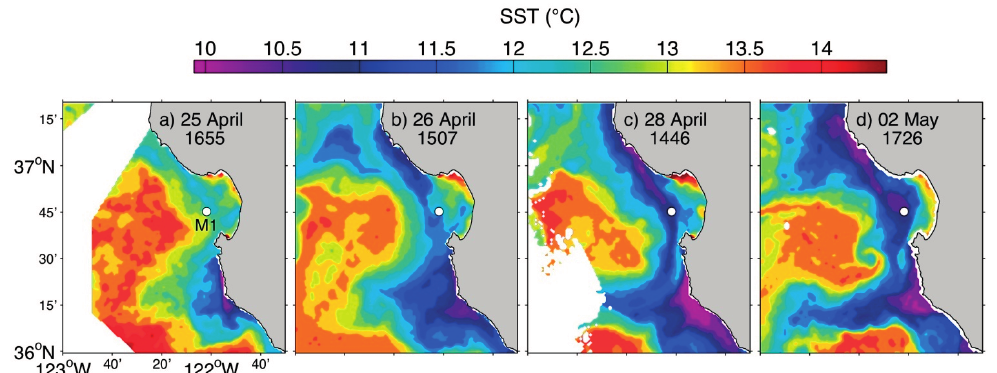
Figure 3. Upwelling intensification during the spring 2011 study. Sea surface temperature (SST) images are from AVHRR; times are